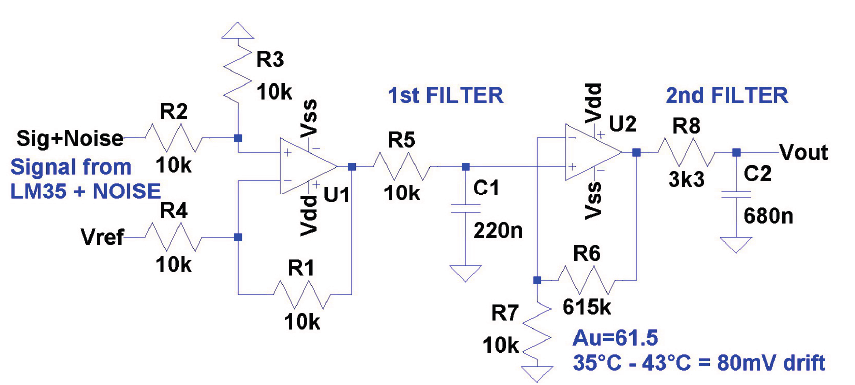
Figure 6. Electric scheme of the temperature sensor realization.